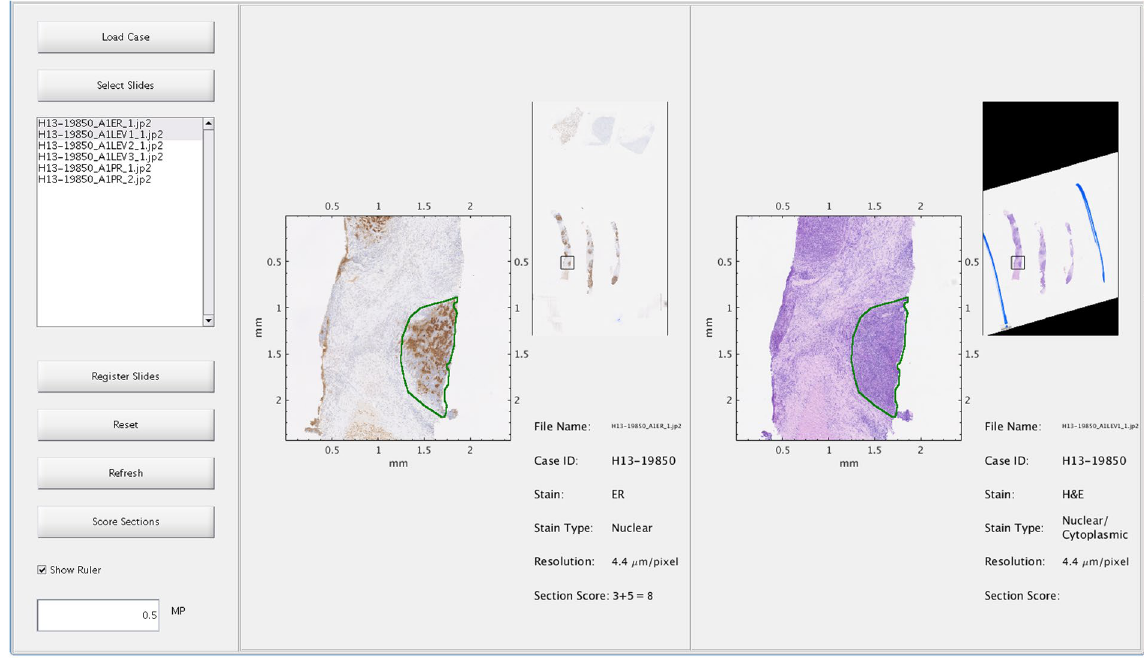
Figure 1. A screenshot of the Hyper-Stain Inspector software. The left panel contains the controls for various functions of the system, such as registration and IHC scoring. This panel also has a list box containing all of the whole slide images within the case, which the user can select or deselect to respectively load or unload the WSI into the system for viewing. Similarly to a slide viewer, loaded slides can be directly navigated to select a visual field for closer inspection. In addition, there are buttons which allow automated algorithms, such as registration and scoring, to be applied. The central and right panels show WSIs that have been loaded for viewing. Each panel contains a close-up viewing area (left), a view of the whole slide (top-right), and any auxiliary information about the slide (bottom-right). The slides shown have been registered and scored, the score is shown in the bottom-right, labelled as “Section score”, in addition, the area that was selected for scoring is highlighted on each image by a green